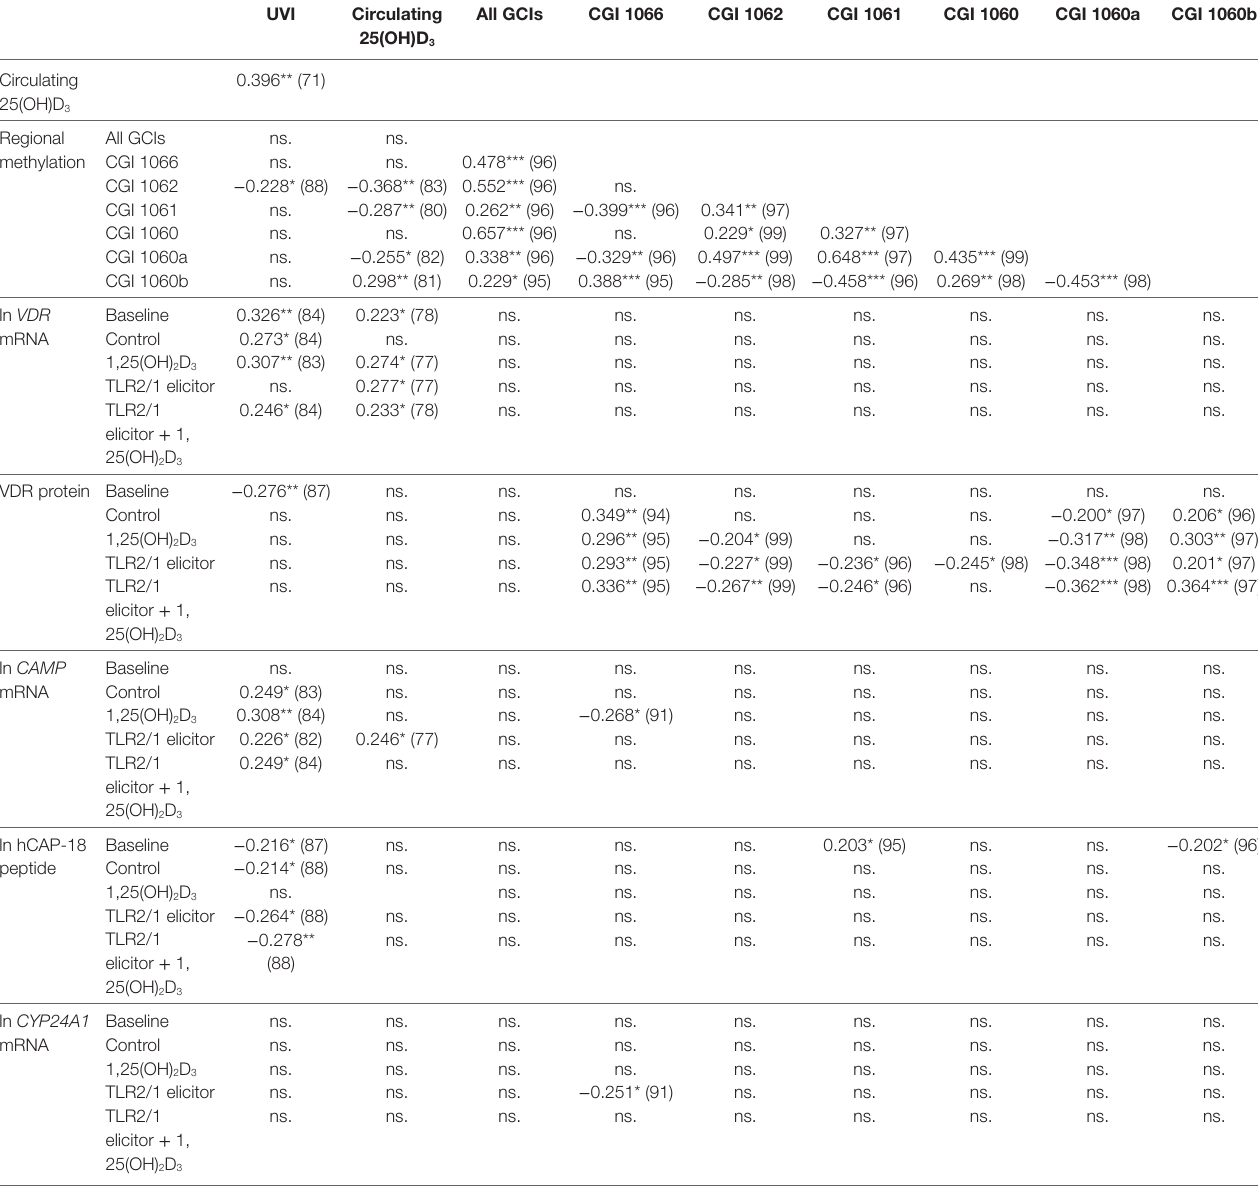
TaBle 3 | Significant correlations between independent environmental variables [season (UVI), plasma 25(OH)D 3 concentration] and dependent TLR2/1-VDR signaling variables, marking VDR expression ( VDR mRNA, VDR protein) and function ( CAMP mRNA, CYP24A1 mRNA, hCAP-18 protein) a